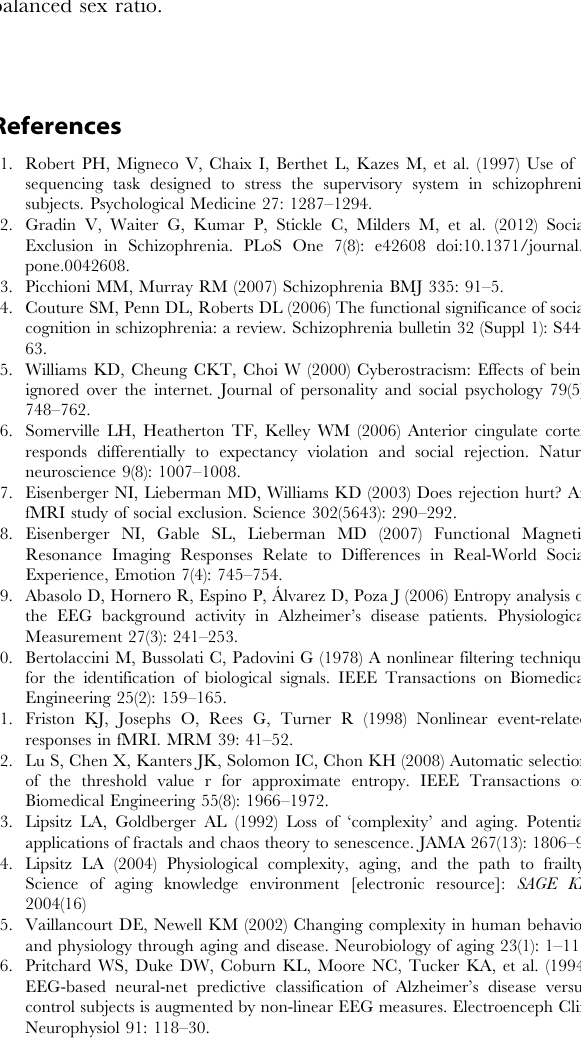
Figure S1 ROC area for detecting mean whole brain SampEn difference between controls and patients with schizophrenia for different tolerance values,